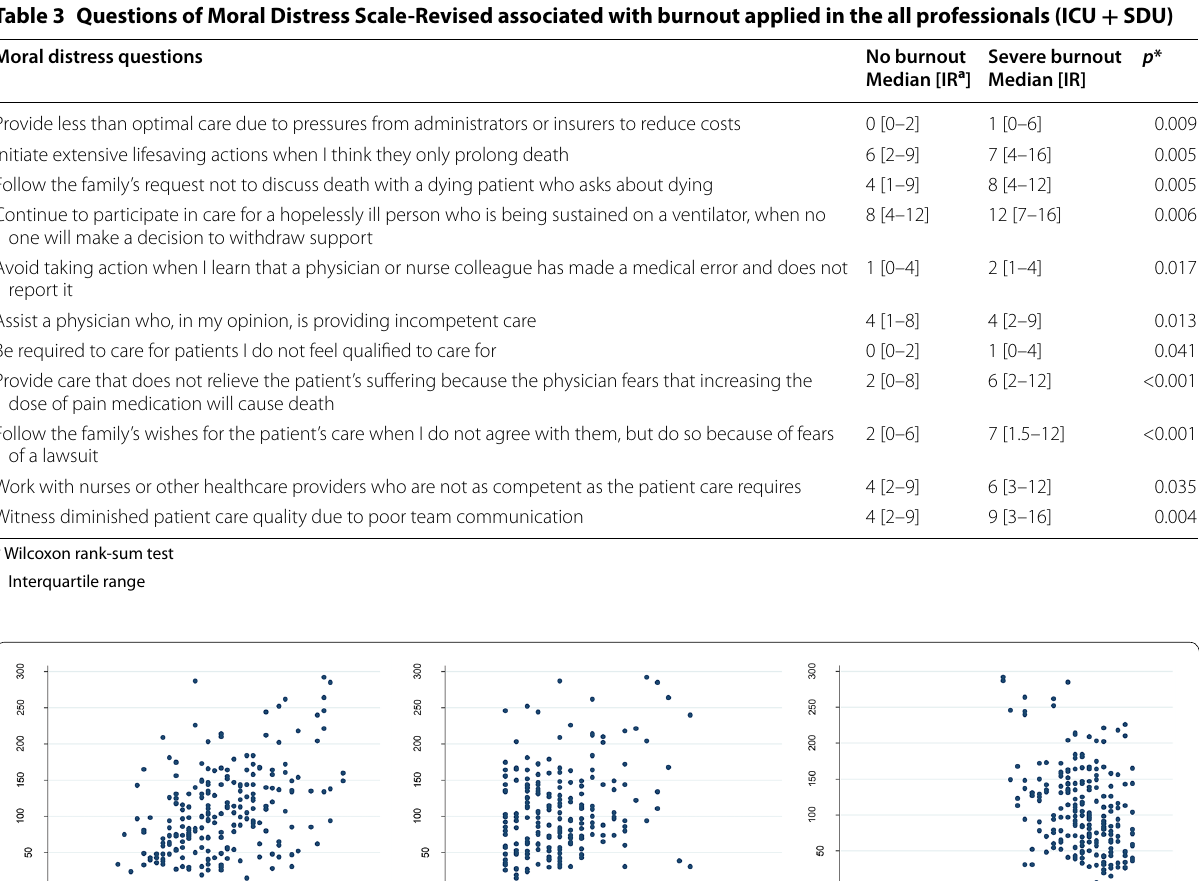
Table 3 Questions of Moral Distress Scale-Revised associated with burnout applied in the all professionals (ICU